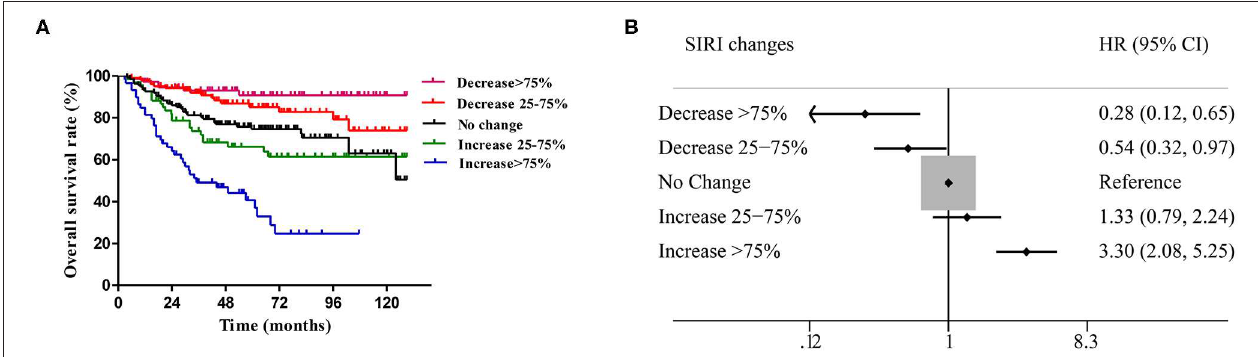
FIGO, International Federation of Gynecology and Obstetrics; SIRI, systemic inflammation response index; NLR, neutrophil lymphocyte ratio; PLR, platelet lymphocyte ratio; MLR, monocyte lymphocyte ratio; HR, hazard ratio; CI, confidence interval; Ref, reference. * Statistically significant (P < 0.05).